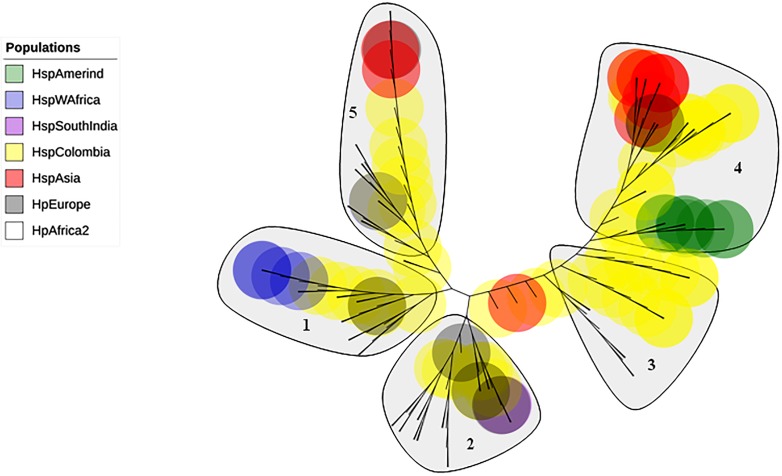
Phylogenetic tree of AlpA proteins of Helicobacter pylori.The evolutionary history was inferred using the Neighbor-Joining method. The optimal tree with the sum of branch length = 0.84663616 is shown. The percentage of replicate trees in which the associated taxa clustered together in the bootstrap test (1,000 replicates); significant consensus tree branches are showed. The evolutionary distances were computed using the JTT matrix-based method and are in the units of the number of amino acid substitutions per site. The rate variation among sites was modeled with a gamma distribution (shape parameter = 2). The analysis involved 142 amino acid sequences. All positions containing gaps and missing data were eliminated. There were a total of 451 positions in the final dataset. Five major clades were detected: (1) Cluster sequences from HspWestAfrica, HspColombia and HpEurope; (2) Cluster sequences from HpEurope, HspSouthIndia and HspColombia; (3) Cluster sequences from HspColombia; (4) Cluster sequences from HpAsia, HspAmerind and HspColombia; and (5) Cluster sequences from HpEurope, HpAsia and HspColombia.